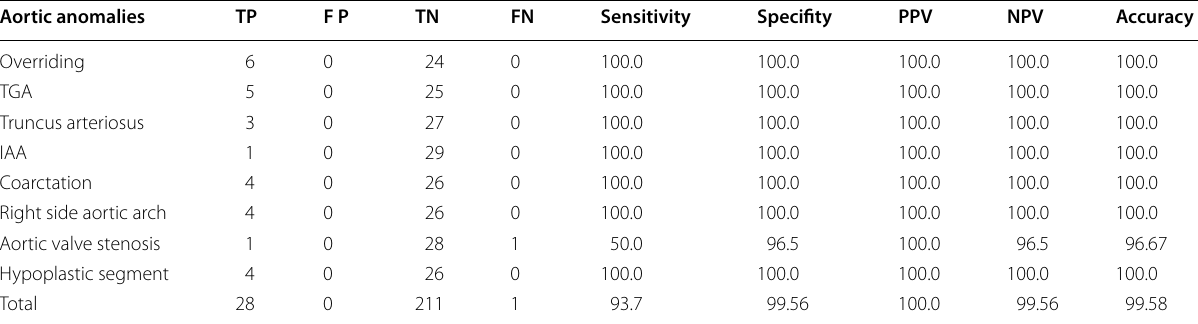
Table 6 Aortic anomalies detected by MDCT angiography compared to surgical and or cardiac catheterization Aortic